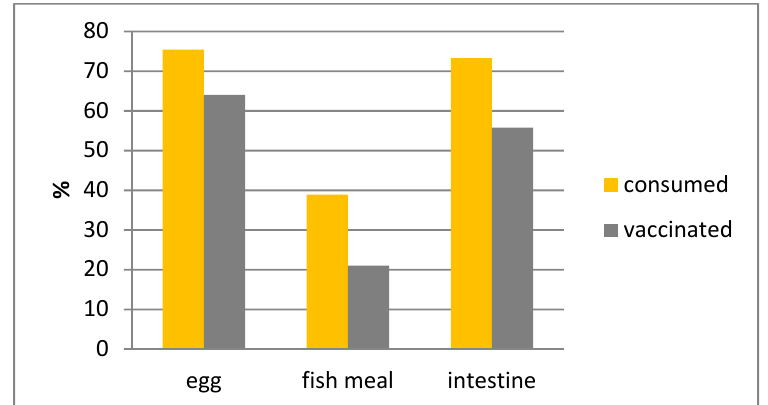
Figure 3. The percentages of dogs consuming the offered bait type and were subsequently considered vaccinated (release of contents of vaccine capsule in oral cavity).